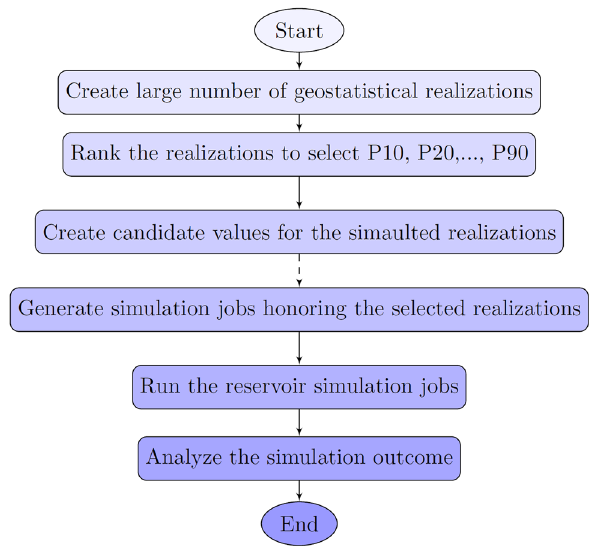
Fig. 9 Flow chart of geological uncertainty of the cyclic GAGD pro- cess